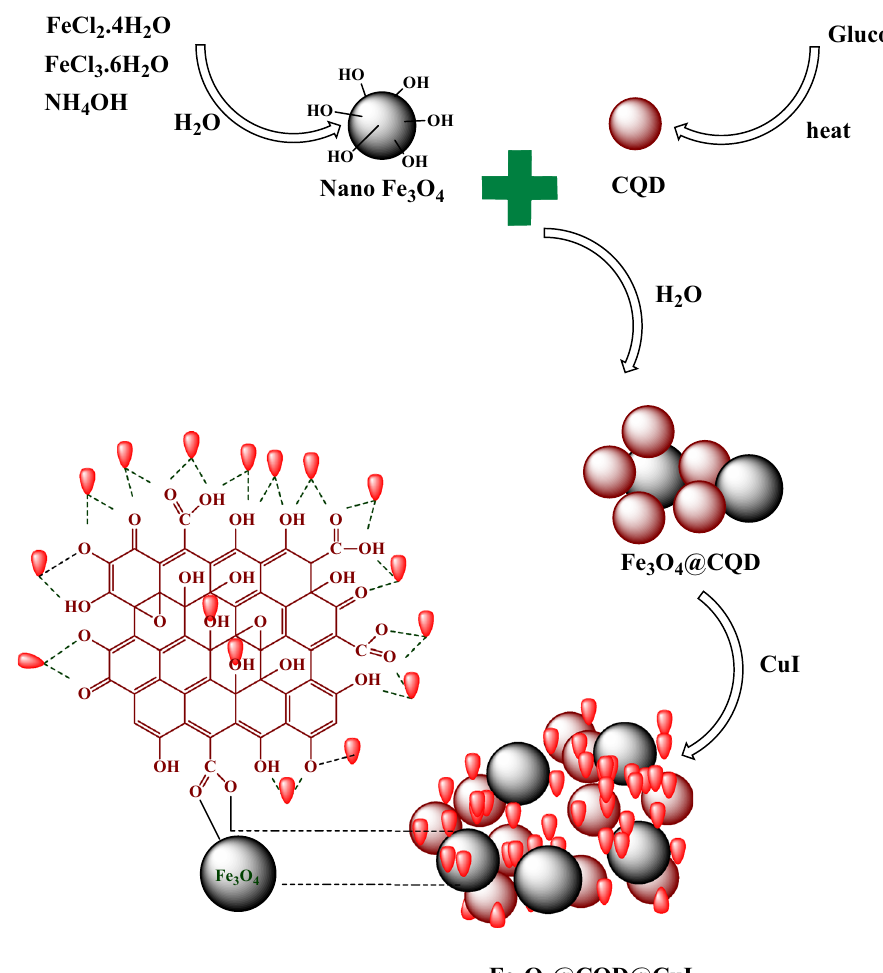
Figure 2. Schematic diagram of Fe 3 O 4 @CQD@CuI synthesis 3